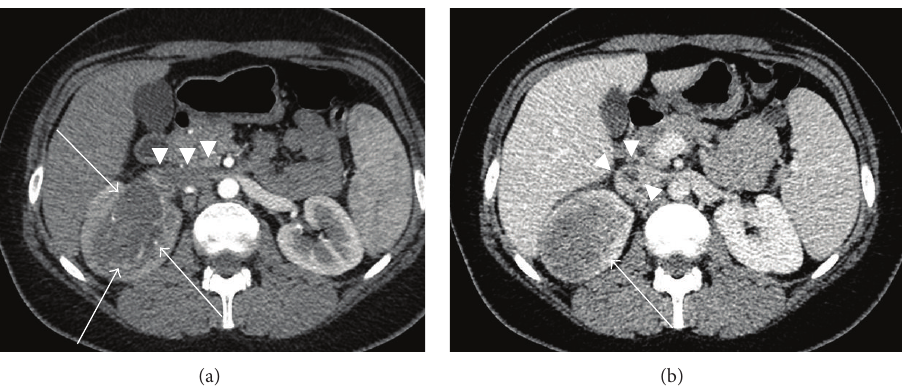
Figure 4: (a, b) Axial venous phase postcontrast CT images (a, b) from the mid-portion of the kidneys. There is a hypoattenuating mass lesion involving the right central part of the kidney with sinus extension (arrows). Hypodense thrombus materials are seen in both right renal vein and inferior vena cava